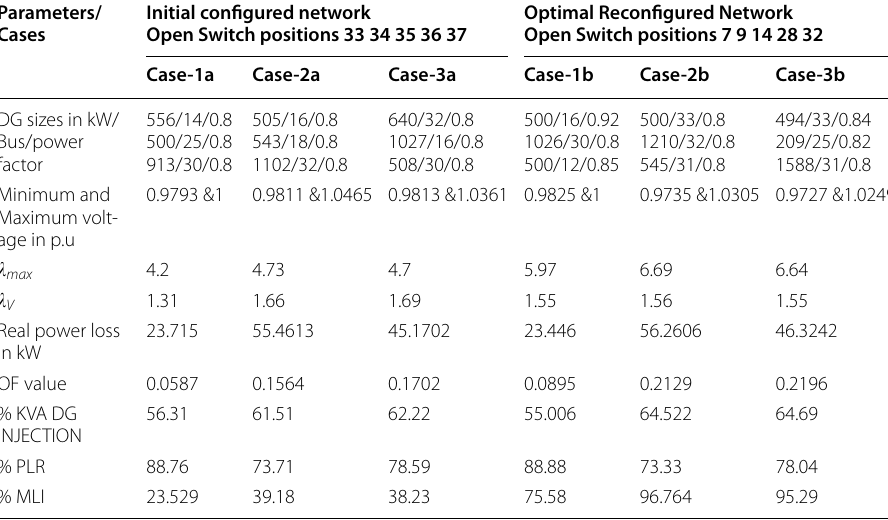
Table 4 Simulation results of 33 bus system for scenario-2 Parameters/